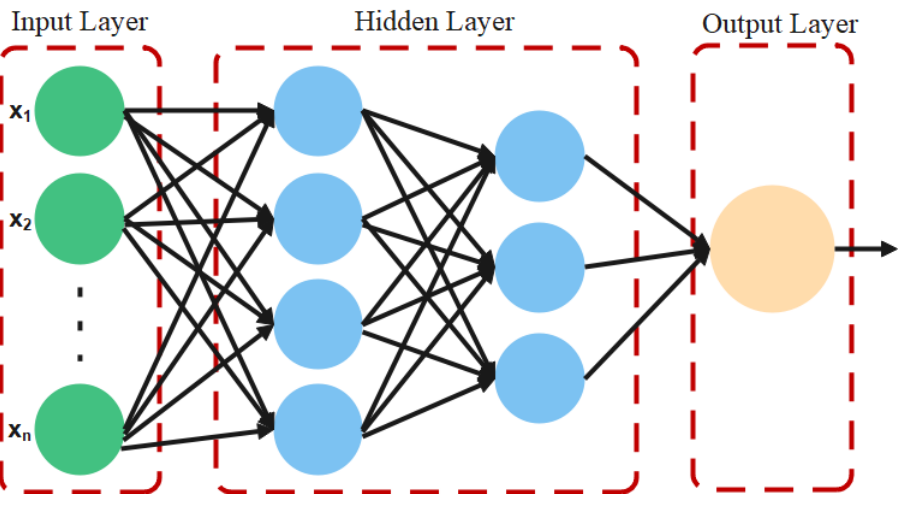
Figure 10. Three Layered Neural